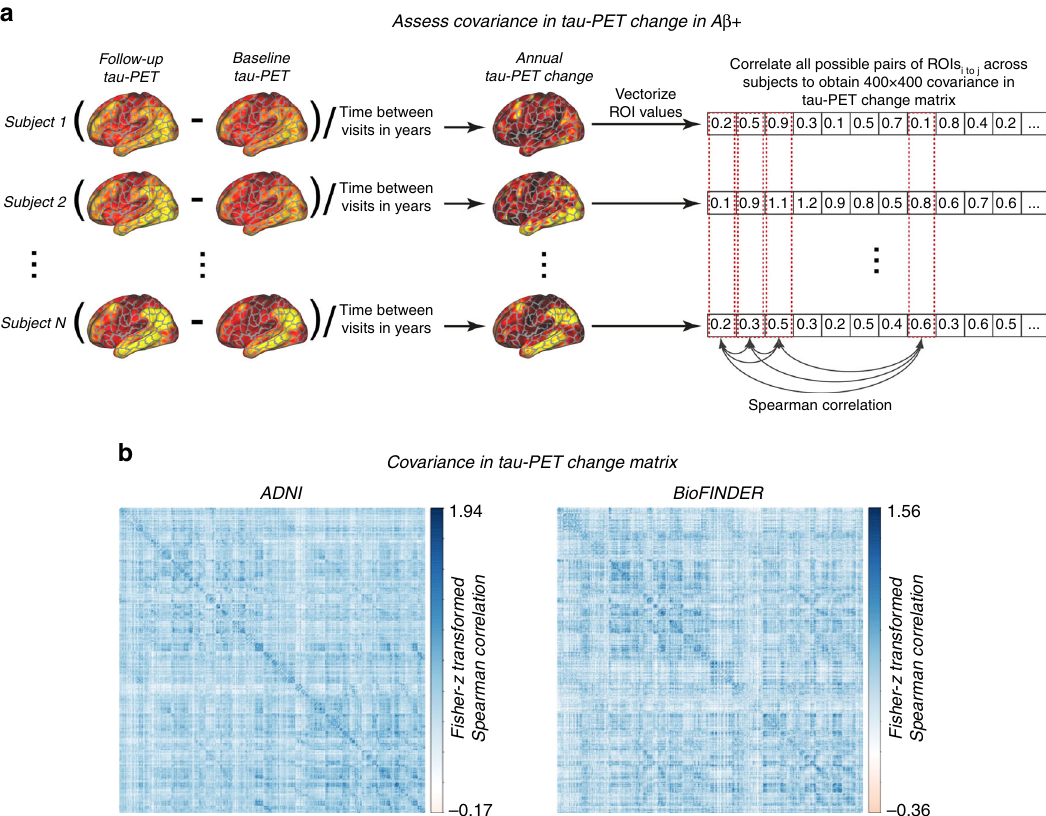
Fig. 3 Assessment of covariance in tau-PET change. a Assessment of covariance in tau-PET change. In a fi rst step, annual change in tau-PET was determined as the ROI-wise difference in tau-PET between baseline and follow-up divided by the time between both tau-PET assessments in years. ROI- speci fi c annual tau-PET change scores were vectorized for each of the A β + subjects within each sample, yielding subject-speci fi c 400-element vectors. Within the A β + groups of the ADNI ( N = 53) and BioFINDER ( N = 41) samples, the subject-speci fi c 400-element vectors were concatenated across subjects to a 53 × 400 (ADNI) and 41 × 400 (BioFINDER) matrix, where we assessed the Spearman correlation in tau-PET change between ROIs across subjects, yielding a ( b ) 400 × 400 covariance in tau-PET change matrix for each sample that was subsequently Fisher-z